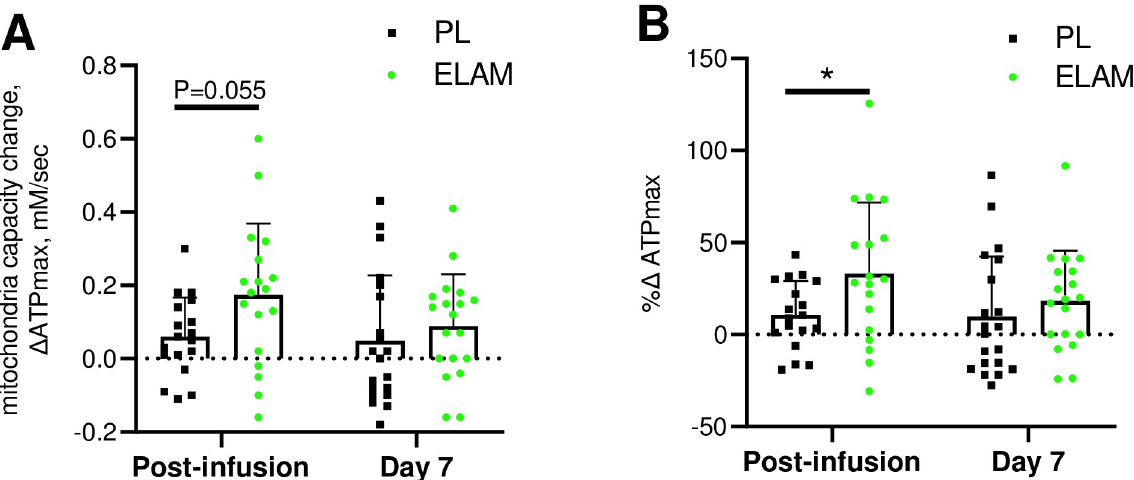
Fig 2. Change in mitochondrial energetic capacity ( Δ ATP max ) with ELAM treatment. Change from baseline with ELAM treatment (post- infusion) and from baseline 7 days post-infusion (day 7). A) Absolute change in ATPmax; B) % change relative to baseline value. Error bars show SD. ELAM = elamipretide; PL = placebo.